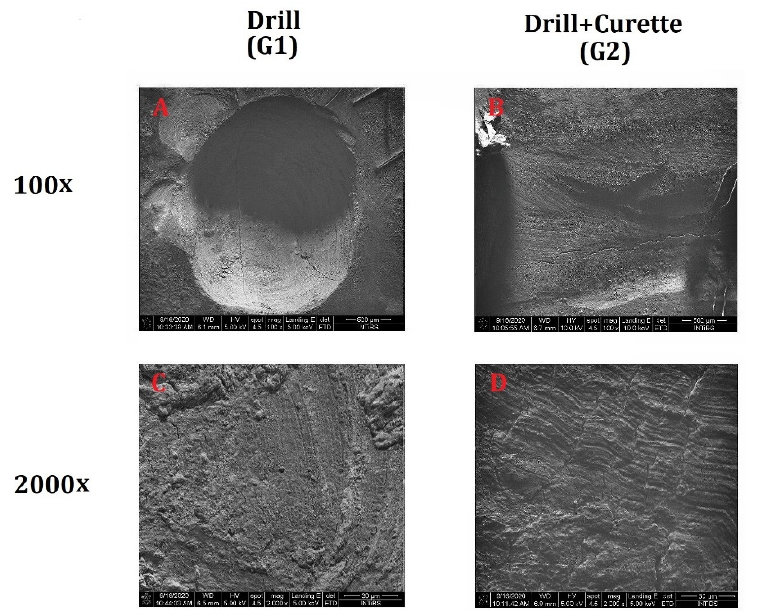
Figure 1. Dentin surface after removal of the composite filling using a diamond drill ( A , C ) and after additional cleaning of the dentin using a dental curette ( B , D additional cleaning of the dentin using a dental curette ( B , D ).